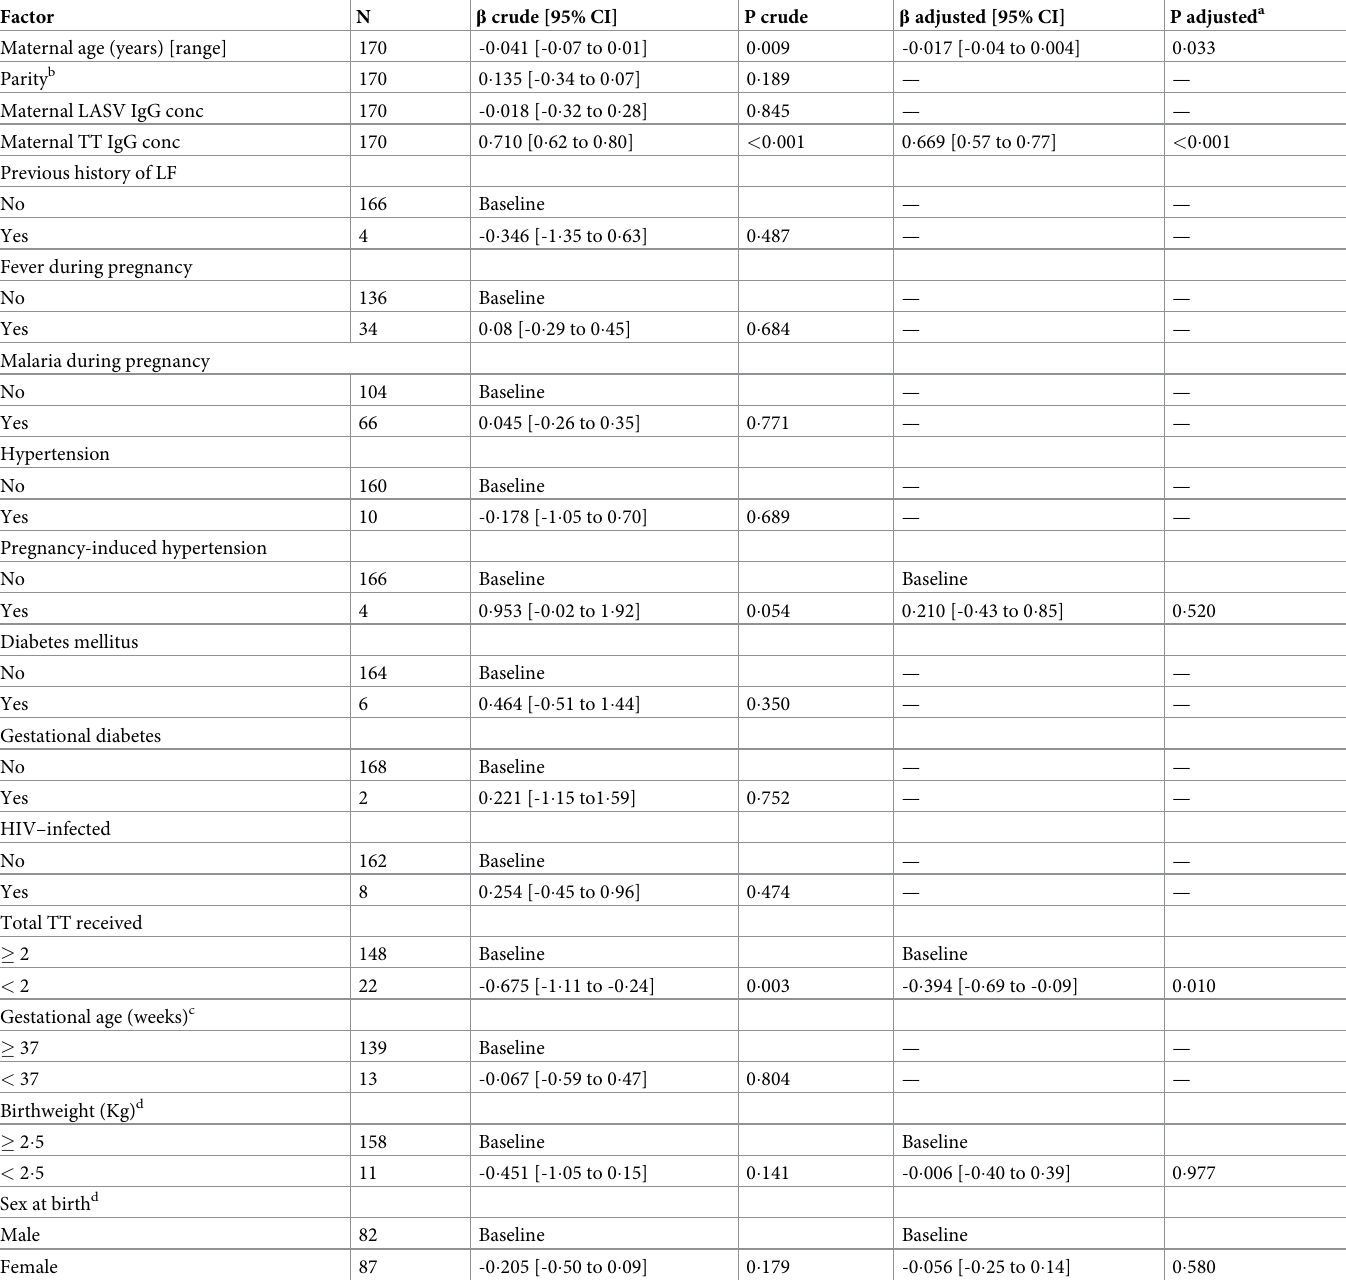
Table 5. Linear regression analysis for the effect of maternal or neonatal characteristics on TT IgG cord concentrations.